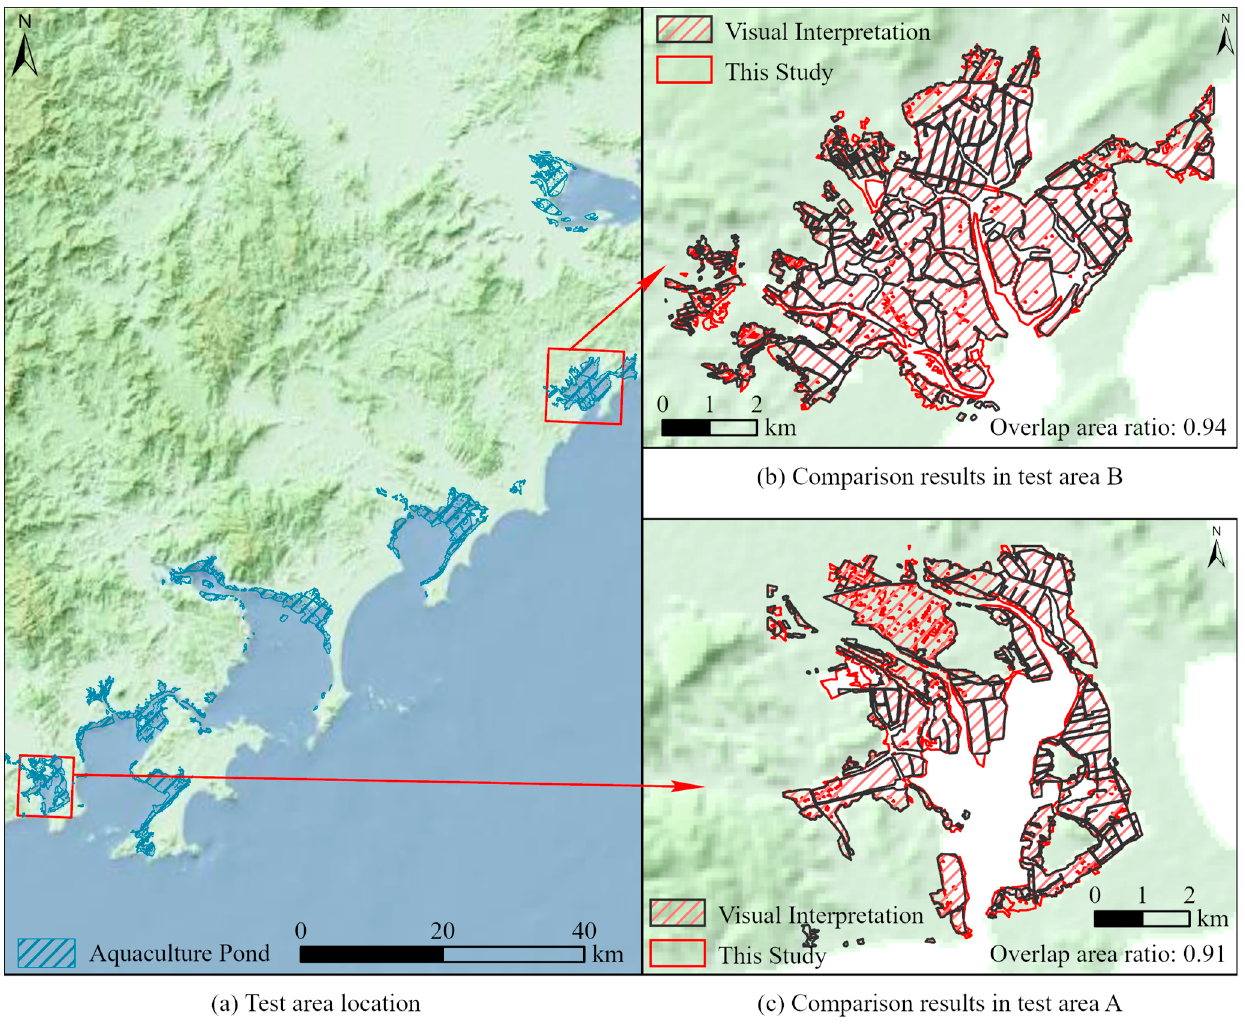
Figure 12. Overlapping proportions of results between automated extraction and visual interpreta- tion.